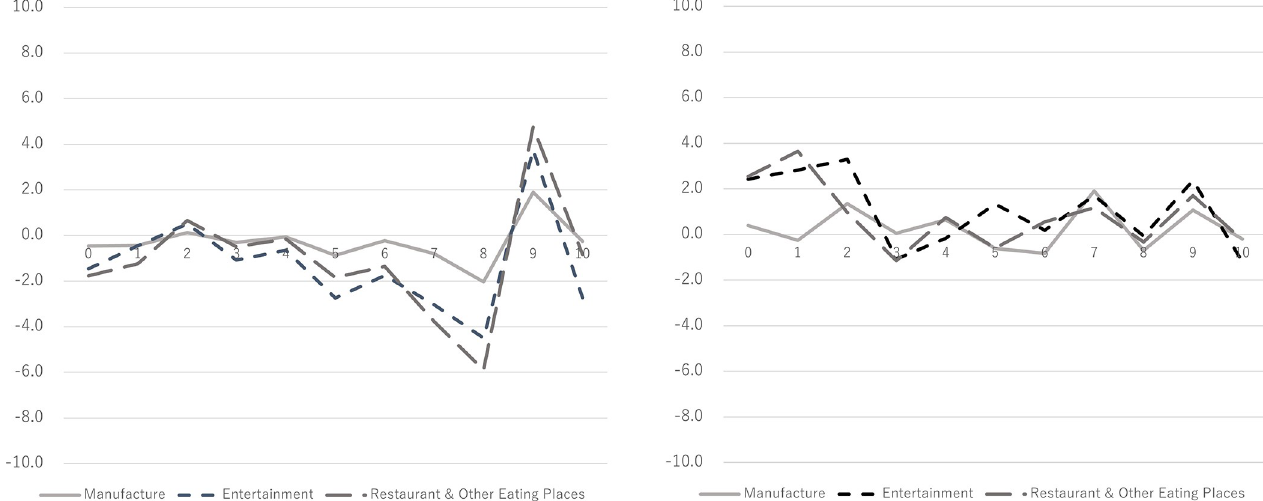
Fig 2. AAR during the two events. A: This is the Panel 1 Fig 2 (Panel 1. February 17th). B: This is the Panel 2 Fig 2 (Panel 2. April 7th). Note. AAR stands for the average of abnormal returns.